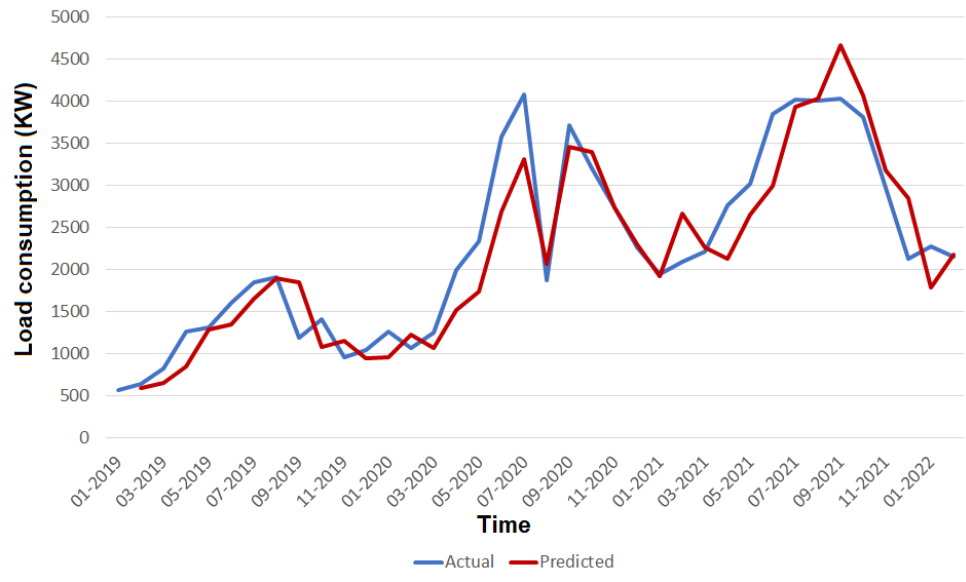
Figure 16. Actual and predicted load consumption values in KW versus time for one district of Dubai using the ARIMA model.